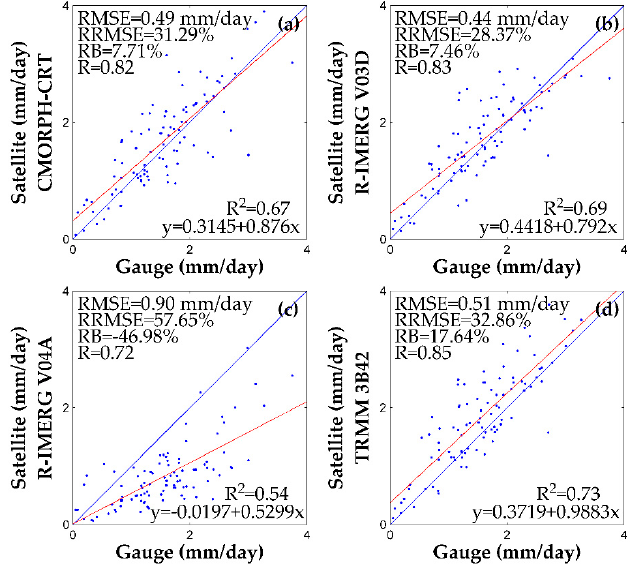
Figure 3. Scatterplots of satellite-based daily average rainfall estimates versus ground-based rain gauge daily average observations for CMORPH-CRT ( a ); R-IMERG V03D ( b ); R-IMERG V04A ( c ); and TRMM 3B42 ( d ) over the Tibetan Plateau during the period June 2014–November 2015. The blue and red oblique solid lines denote a 1:1 line and a least-squares regression line, respectively.